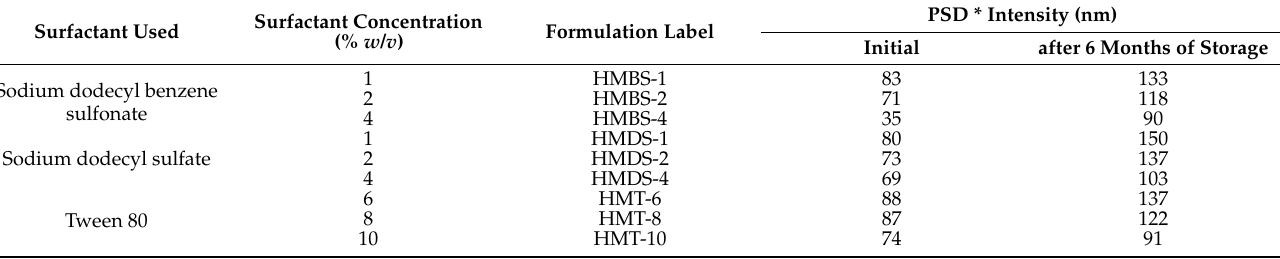
Table 1. Particle size distribution (modes) of the hexaconazole-micelle nanodelivery systems using various surfac- tant